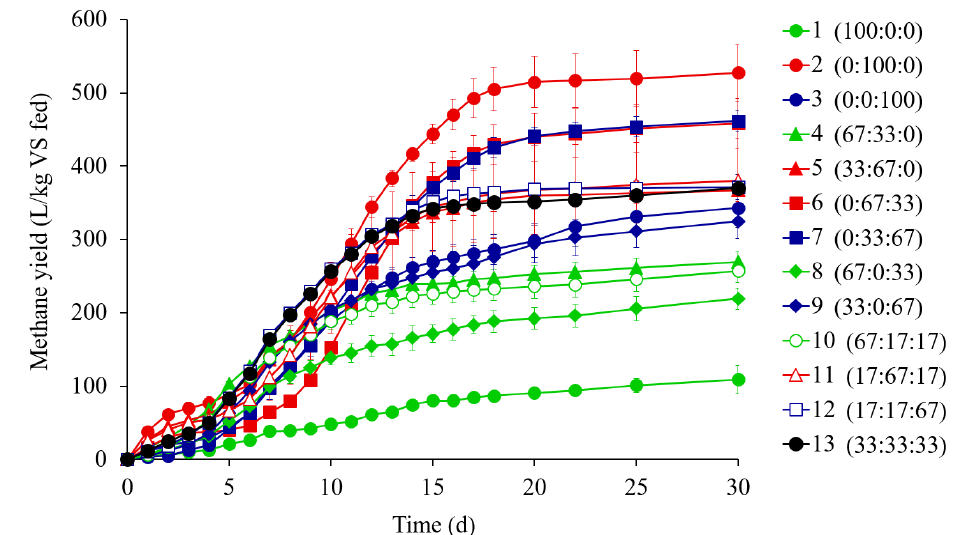
Figure 1. Cumulative methane production in the batch co-digestion tests with cattle manure (CM), food waste (FW), and pig manure (PM). Curves are labeled with the corresponding run numbers (percentage mixing ratio of CM: FW: PM on a total solids basis). Error bars indicate standard deviations ( n = 3). Symbol colors represent the composition of substrate mixtures (total solids basis): green for high-CM runs (≥67% CM), red for high-FW runs (≥67% FW), blue for high -PM runs (≥67% PM), and black for the center point run with an equiproportional mixture of CM, FW, and PM.